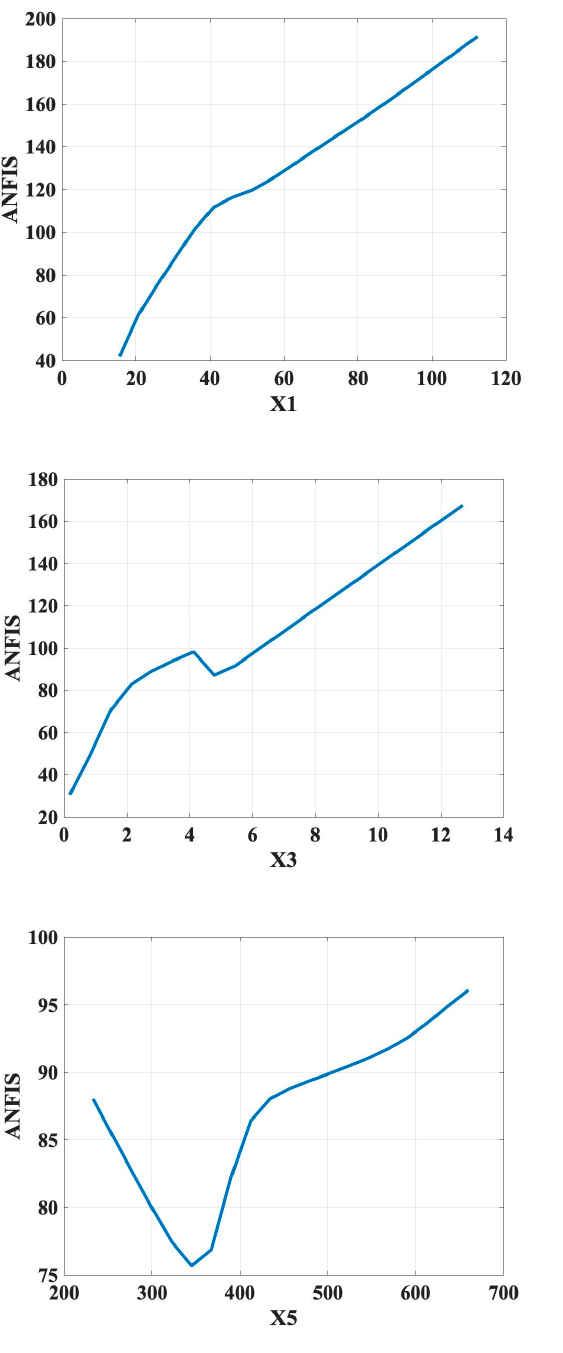
Figure 12. Results of the sensitivity analysis.